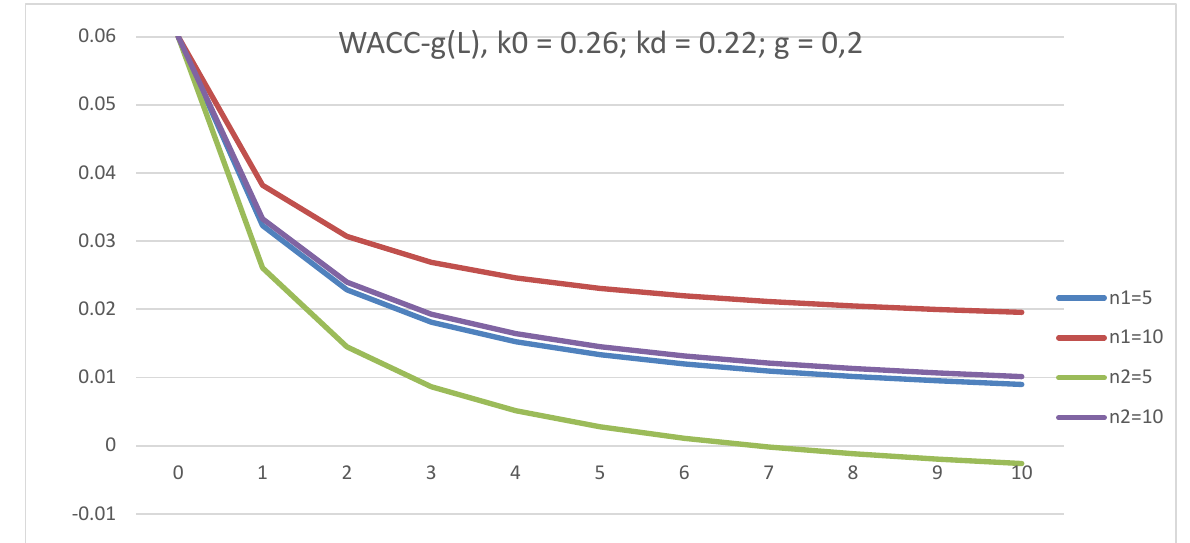
Figure 12. The dependence of discount rate, WACC–g, on leverage level, L, in GBFO theory with payments of tax on profit at the ends of periods (1) and advance payments (2) at k 0 = 0.26; k d = 0.22; t = 0.2; g = 0.2 for five-year and ten-year companies.